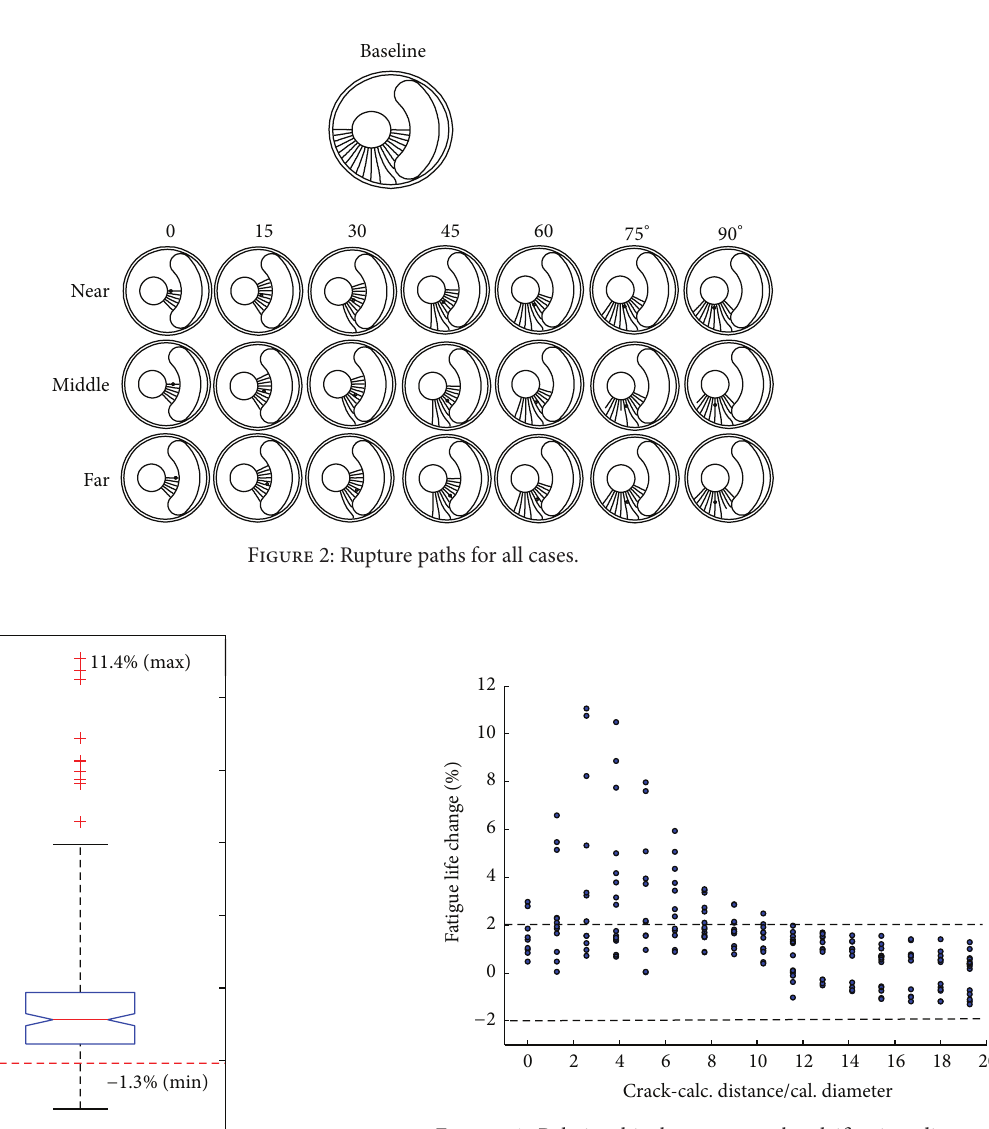
Figure 3: Fatigue life changes (%).